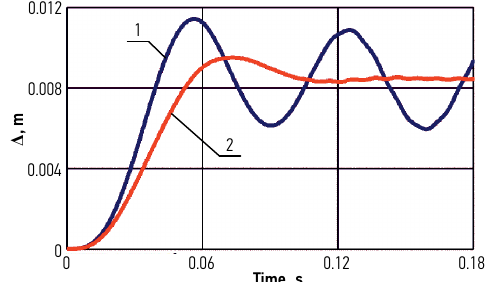
Fig. 5. Calculation results of vertical axis displacement ∆ in the model without water: 1 – not damped tire system;